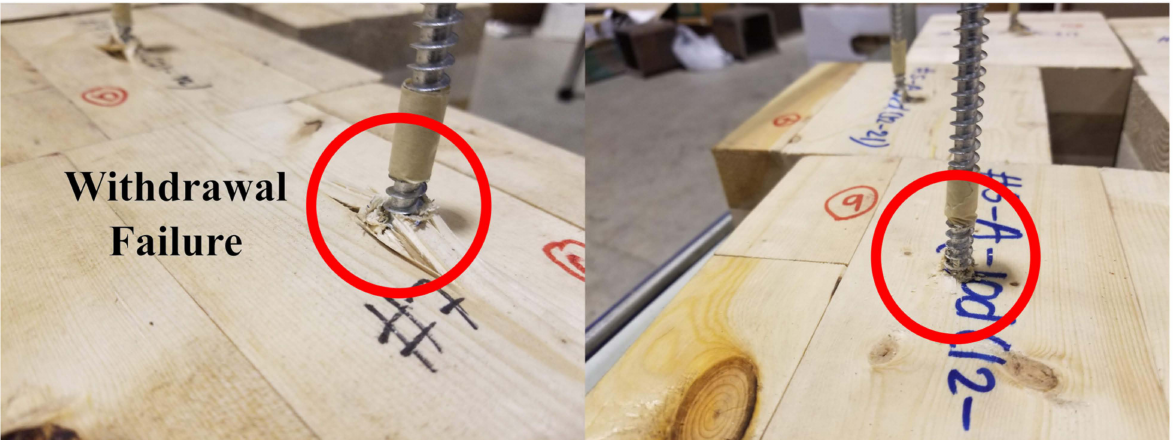
Figure 12. Failure mode in a few specimens after the withdrawal